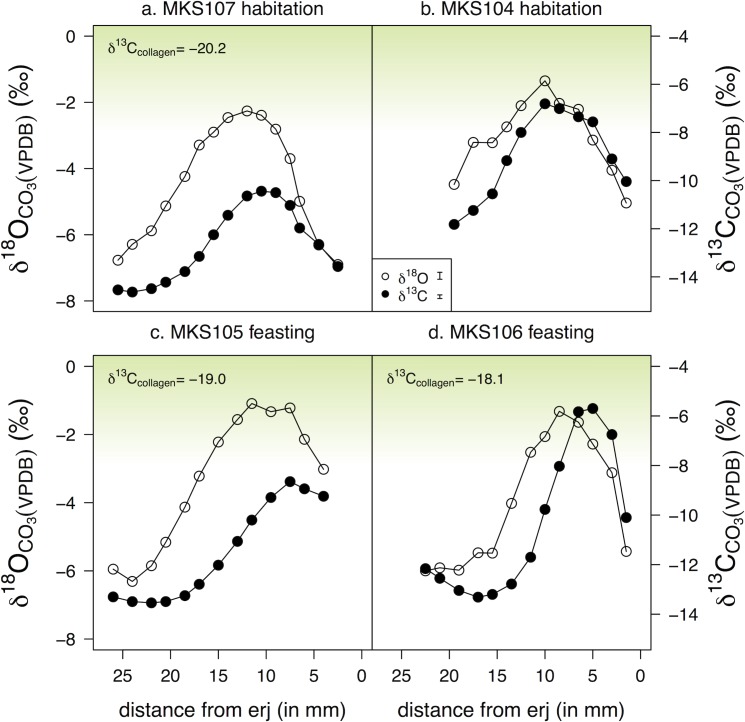
Incremental tooth enamel carbonate δ18O and δ13C values of sheep from Makriyalos I.(a–b) samples from non-feasting contexts (habitation), (c–d) samples from feasting context (Pit 212). Positions of sub-samples are recorded as distance (in mm) from the enamel root junction (erj). δ13C values of matching mandibular collagen (where C/N ratio was acceptable) are included for reference. Green shading indicates theoretical values of consumers with increasing amounts of C4 vegetation in their diet (the lower endpoint is set at -8‰ [38]). Measurement error for each element is shown in the legend.